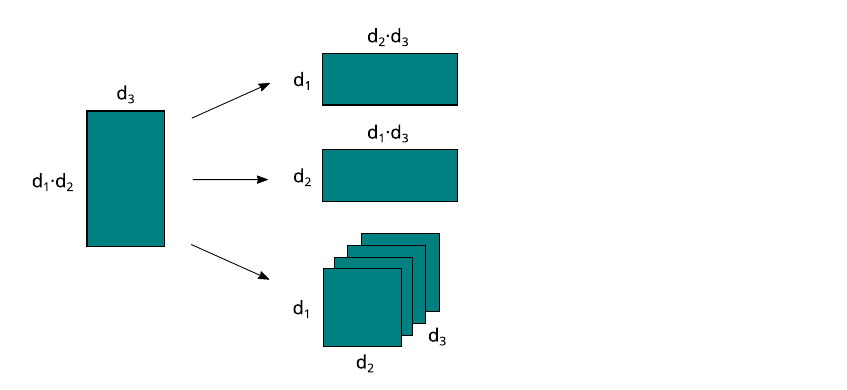
Figure 3. Visualization of the reshaping operation. A matrix of dimensions d 1 d 2 by d 3 , where d 1 , d 2 , d 3 ∈ N , can be reshaped into another matrix of different dimensions (right top and middle) or into am order-3 tensor (right bottom).